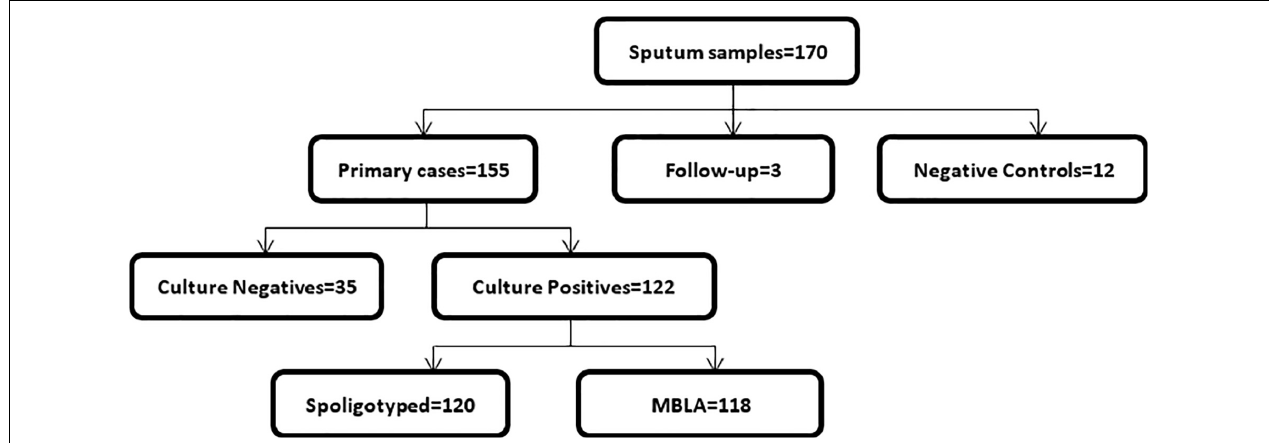
FIGURE 1 | The study workflow of sputum sample